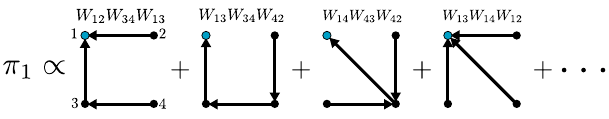
FIG. 8. Matrix-tree theorem. Graphical representation of the steady-state probability π 1 as the sum of all spanning trees rooted at 1 (blue